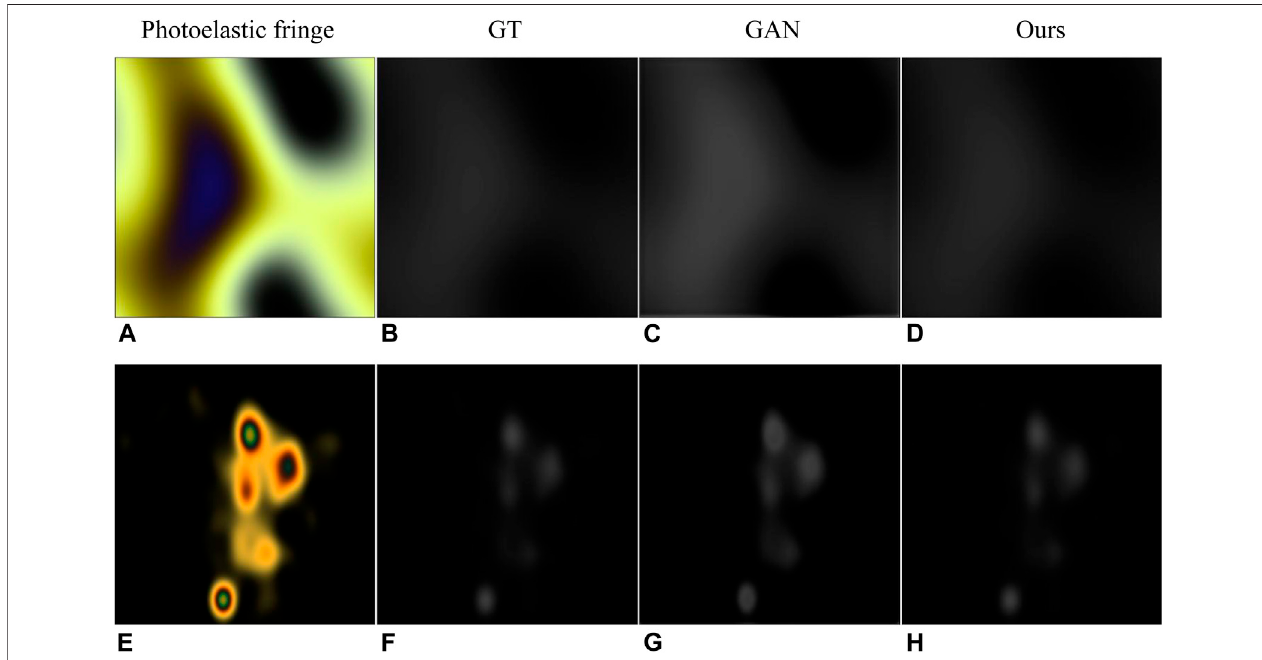
FIGURE 6 | Results of comparison with GAN (Briñez de León et al., 2020c). (A,E) are photoelastic fringes obtained with Willard_LED and incandescent light sources, respectively. (B,F) are corresponding ground truth. (C,G) are the results in the GAN. (D,H) are the results of our method.